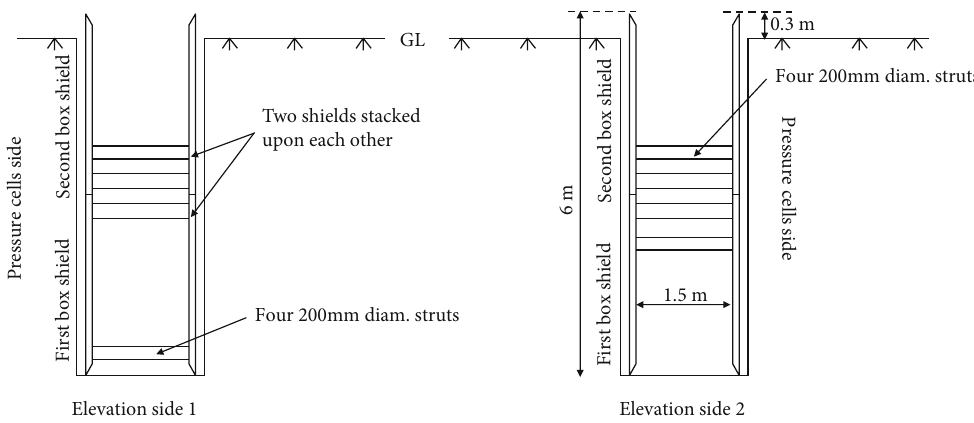
Figure 2: Elevation views of trench and